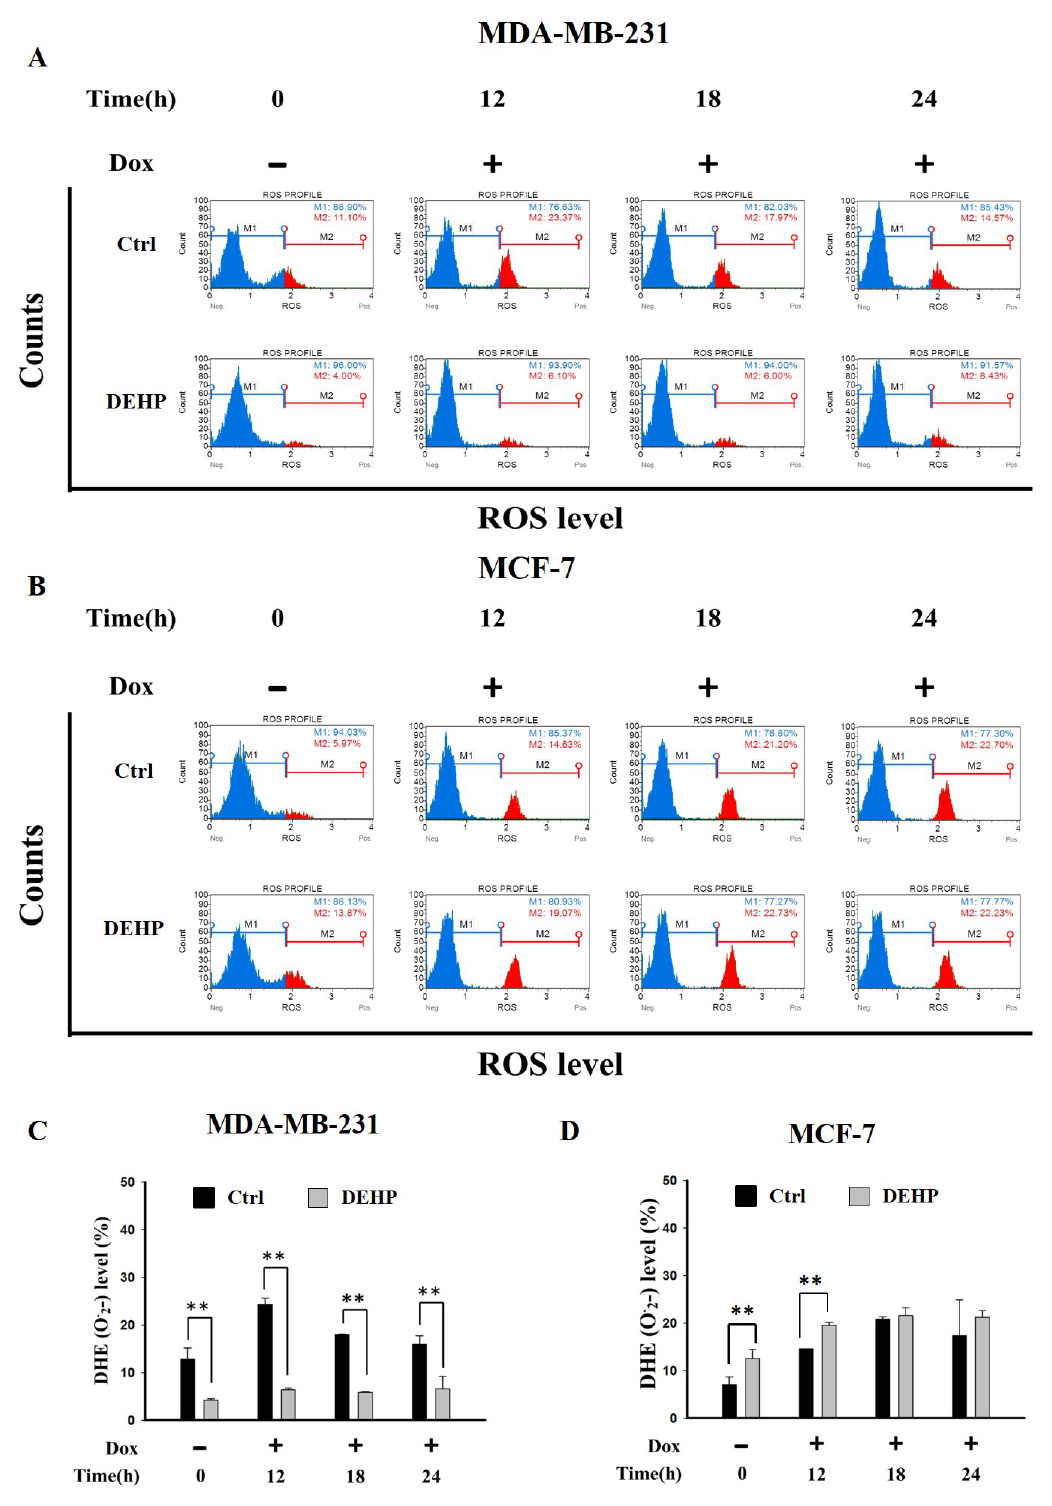
Figure 2. Representative and quantitative analysis of ROS (O 2 − ) determined by DHE staining and flow cytometry analysis. Control and long term DEHP exposed MDA-MB-231 and MCF7 cells were treated with Dox (2 µ M) for 0, 12, 18, and 24 h. Cells were then stained with dihydroethidium (DHE) and analyzed using Guava Muse Cell Analyzer. ( A , C ). MDA-MB-231 cells and ( B , D ). MCF7 cells. ** p <